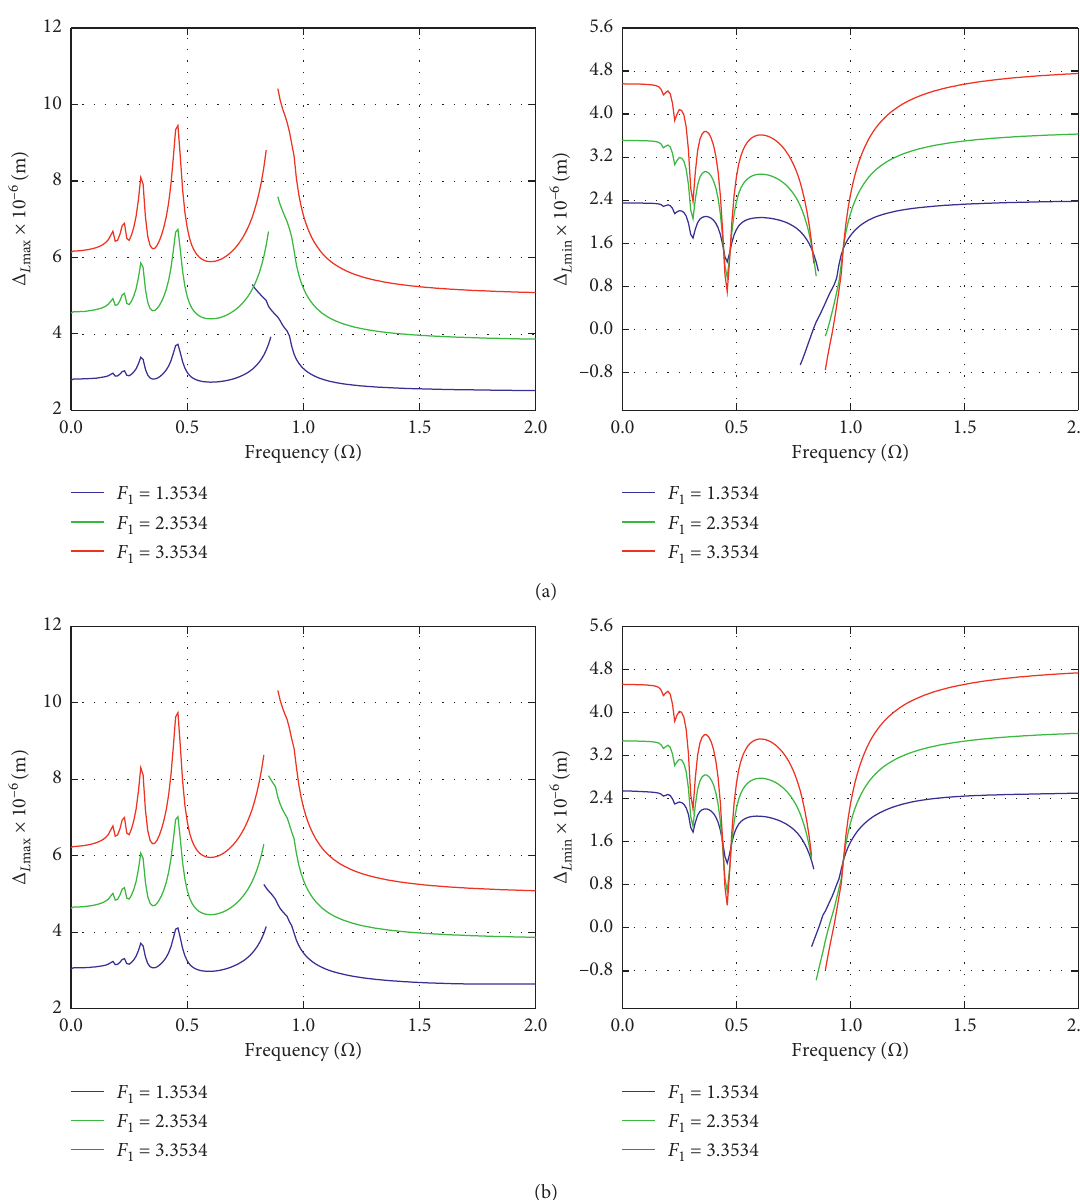
Figure 12: Influence of excitation force amplitude on amplitude frequency characteristic curve of the system. (a) Constant backlash models and (b) dynamic backlash